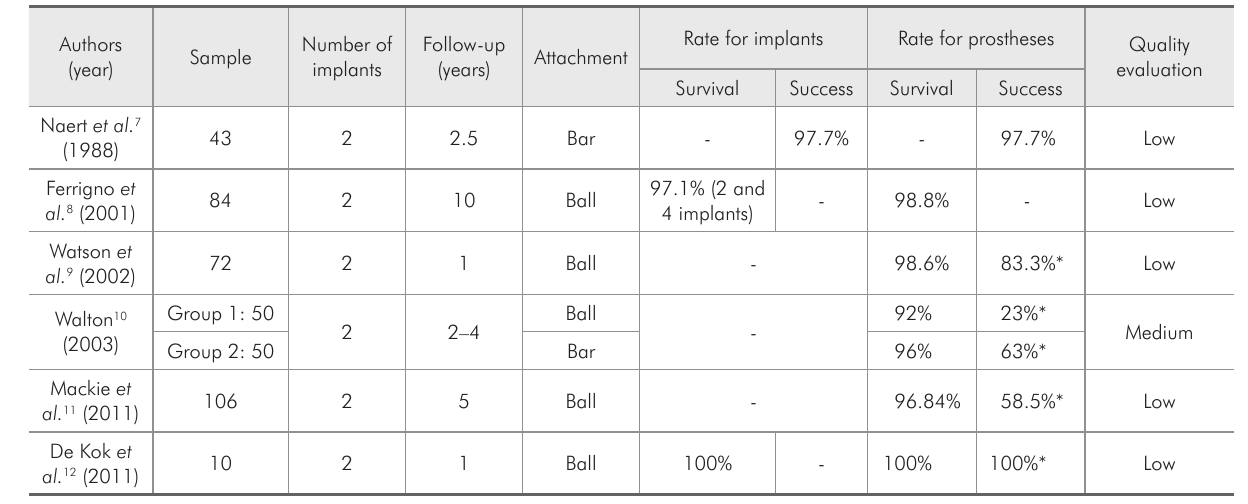
table 1 - Results of studies with two